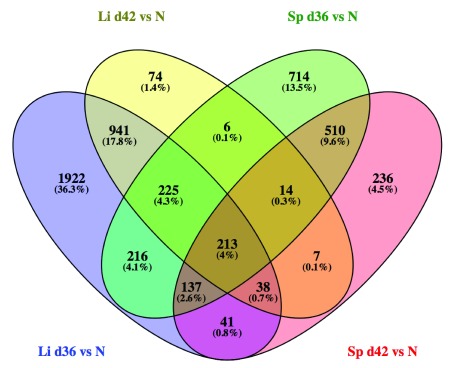
Venn diagram to illustrate overlap in DE genes between all treatment groups.Venn diagram representing all DE genes listed in
Extended data: Table S4 in spleen and liver at each time point after AmBisome
® treatment.